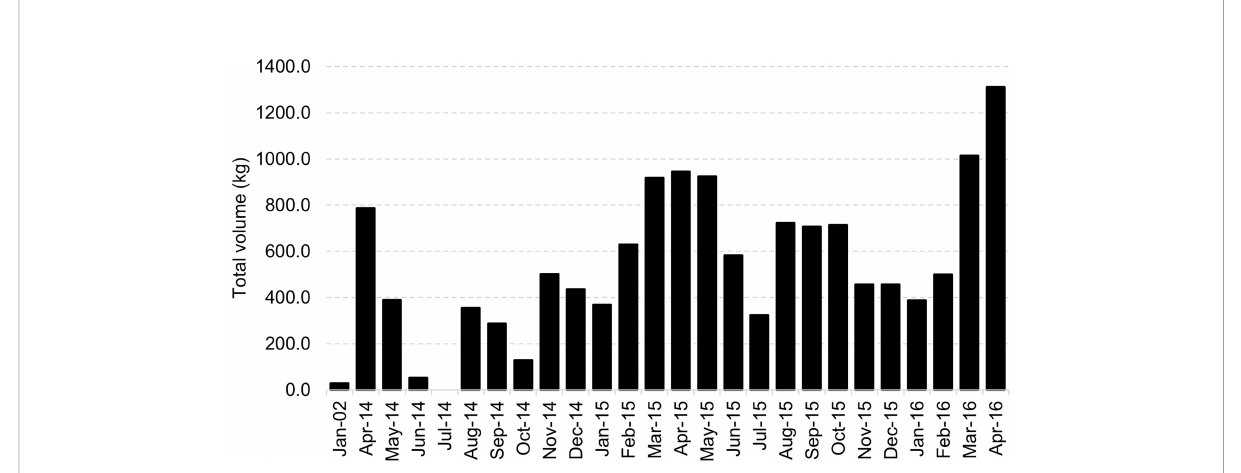
FIGURE 5 Sand fi sh Holothuria scabra landed catch from within Bolinao-Anda Reef Complex in Bolinao, Northwestern Philippines showing the baseline data from January 2002 and the relative increase in sand fi sh as evident in the monitoring data from April 2014 to